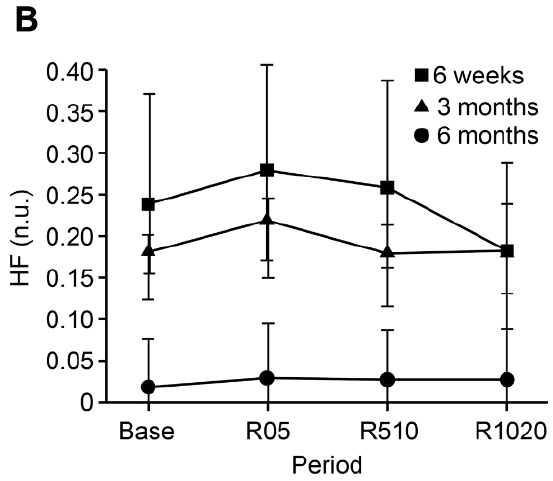
Figure 2. ( A ) Estimated least-square means and 95% confidence intervals of high-frequency power (HF; Hz) for 6-week (6W), 3-month (3M) and 6-month (6M) old calves undergoing CAST (square) and SHAM (triangle) ( B ) Time points evaluated consist of baseline (5 min before treatment; Base), early recovery (0–5 min after treatment; R05), middle recovery (5–10 min after treatment; R510), and late recovery (10–20 min after treatment; R1020).For LFP, there was no evidence for any differences between age groups or treatments over time. For LFP/HFP, evidence for a main effect of age was noted ( p = 0.0059), whereby 6M old calves (estimated least square mean, [95% confidence interval]: 5.35 n.u., [2.75, 10.43]) showed greater LFP/HFP than younger calves (6W: 0.74 n.u., [0.41, 1.33], p = 0.0058; 3M: 1.22 n.u., [0.89, 1.67], p = 0.0044) regardless of SHAM or CAST.